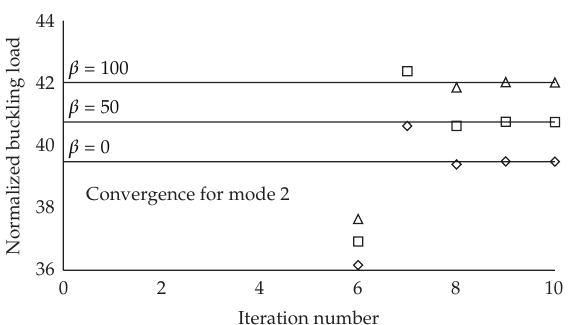
Figure 9: Convergence of solutions through the iterations for the second mode of P-P